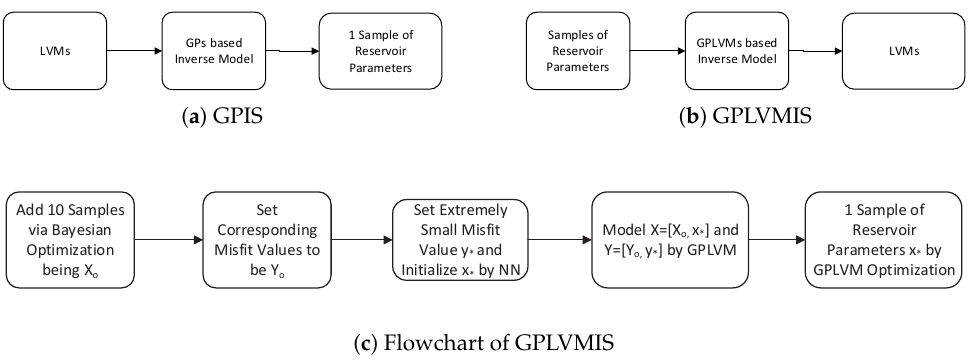
Figure 3. The comparison of GPIS ( a ) and GPLVMIS ( b ) with the flowchart of GPLVMIS in detail ( c